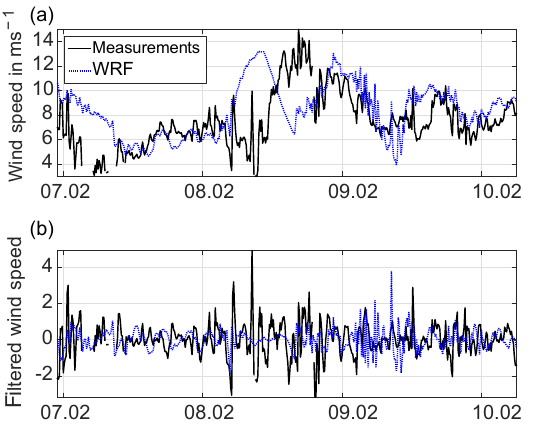
Figure 5. Original wind speed time series of one grid point of the WRF simulation (a) and fluctuation time series after filtering (b)